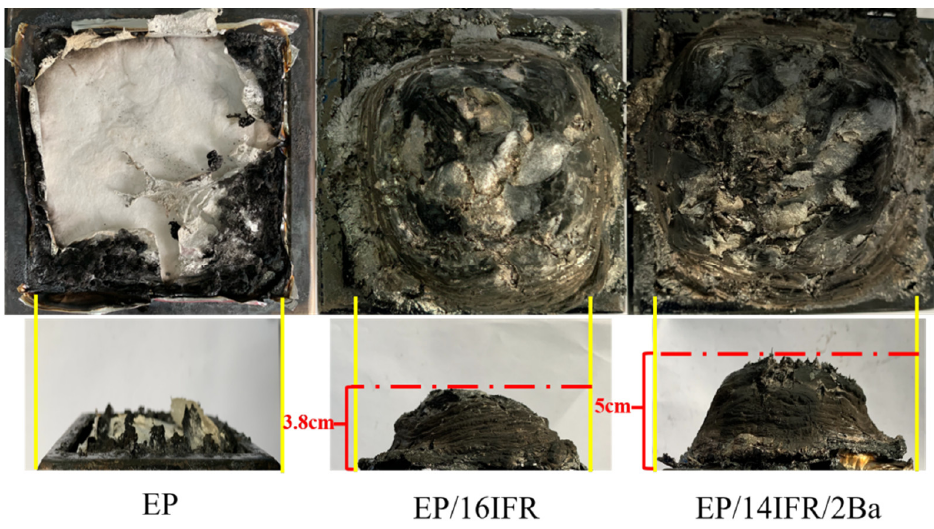
Figure 8. Digital photos of EP, EP/16IFR and EP/14IFR/2Ba after cone calorimeter testing.